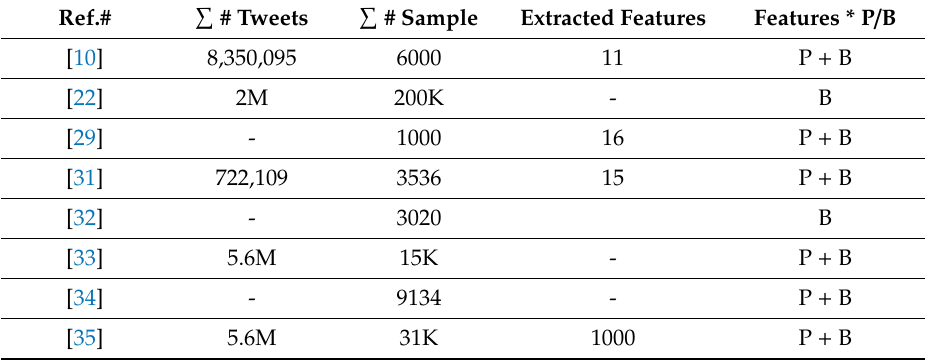
Table 1. Metric selection and data set collection summaries for machine learning.